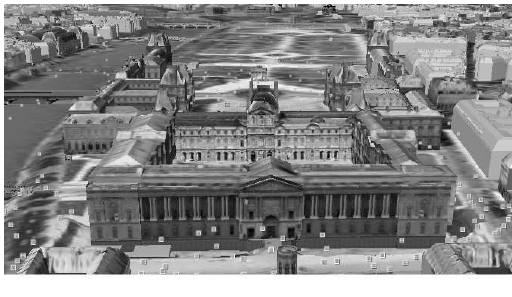
Figure 1: Aerial Photograph of the Louvre showing the Main facade of the East Wing of the Cour Carre courtesy of Google